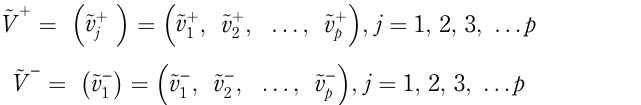
criteria Step 7: Fuzzy positive ideal solution (FPIS) and fuzzy negative solution (FNIS) are obtained from the weighted normalized decision matrix respectively.